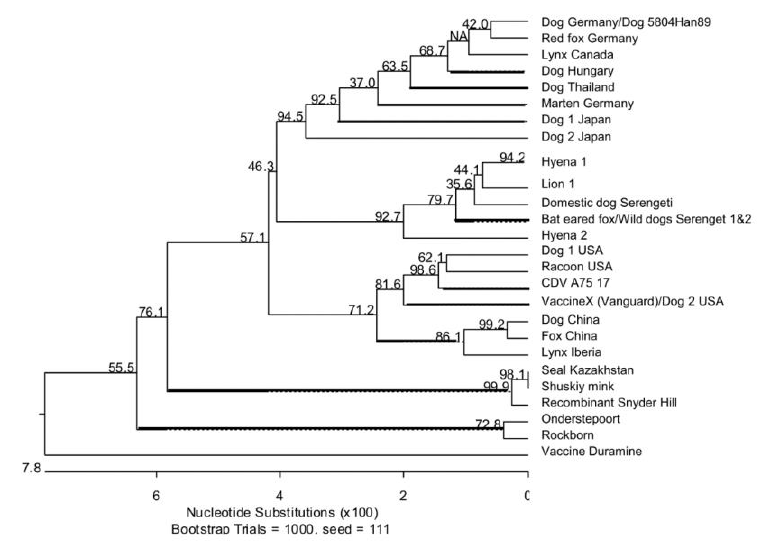
Figure 1. Phylogenetic relationship of CDV strains from the 1993/1994 Serengeti CDV epidemic to other selected strains of CDV available in GenBank based on P gene sequences. Dog Thailand (AB299193.1), Marten Germany (AJ582389.1), Dog 1 Japan (AB294371.1), Dog 2 Japan (007Lm,